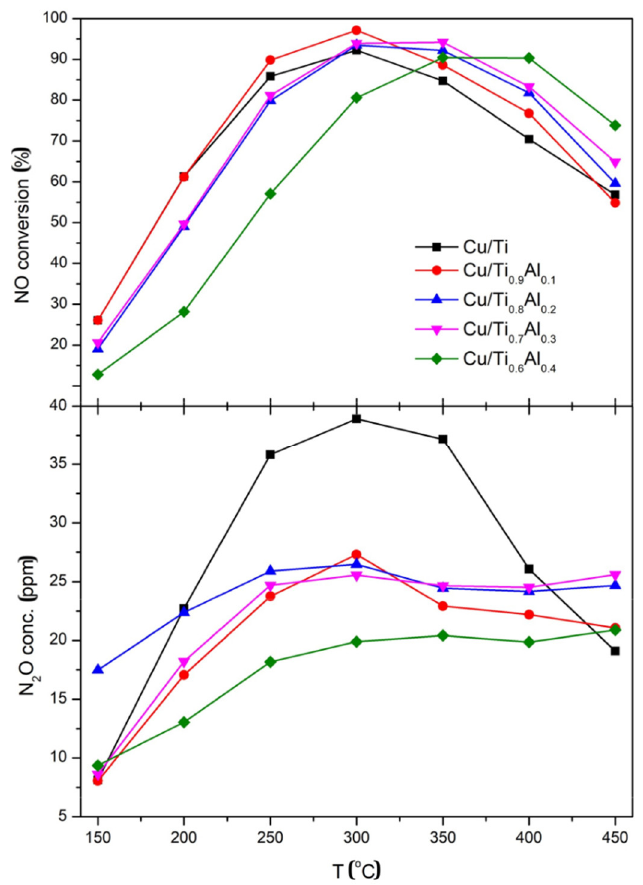
Figure 7. NO conversion and N 2 O concentration over Cu/Ti x Al 1-x